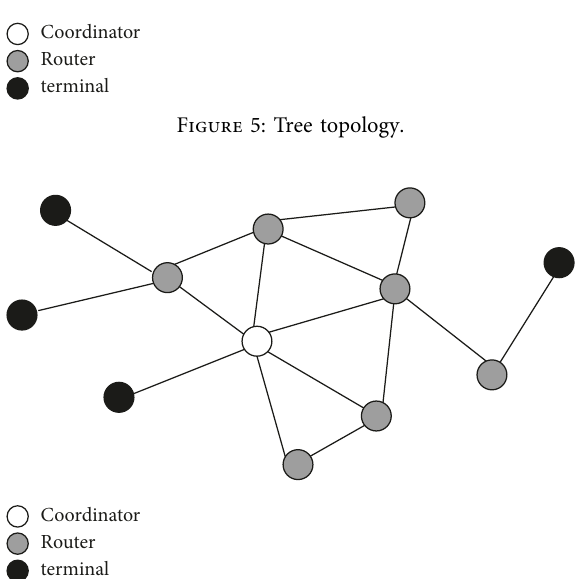
Figure 5: Tree topology.